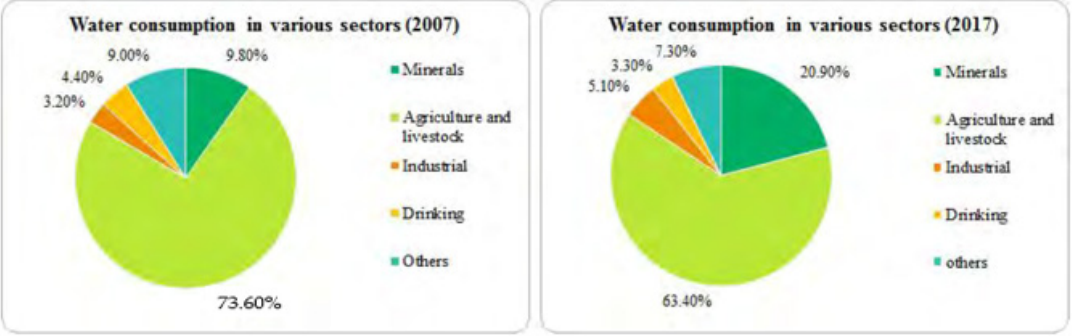
Figure 2. Water consumption in the Atacama Region (Region III) of Chile [4].